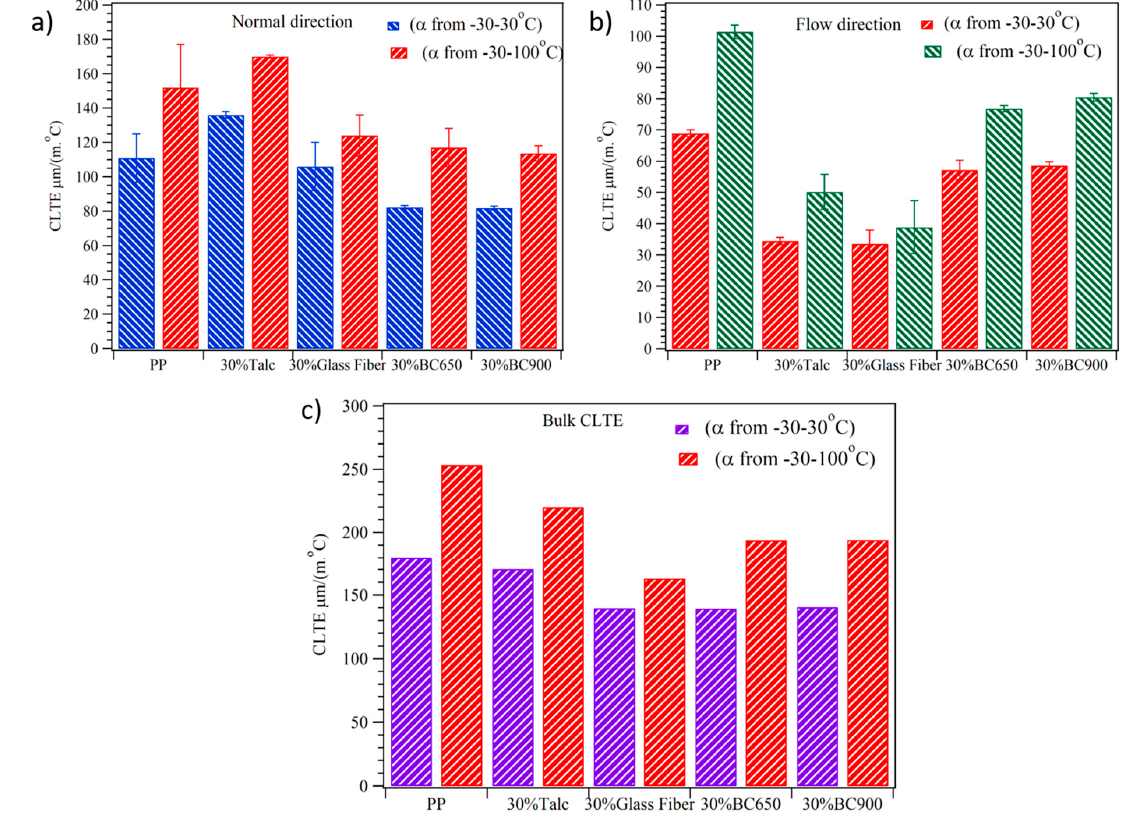
Figure 6. CLTE of PP-filler composites in two different temperature ranges: ( a ) normal direction, ( b ) flow direction, and ( c ) bulk CLTE.